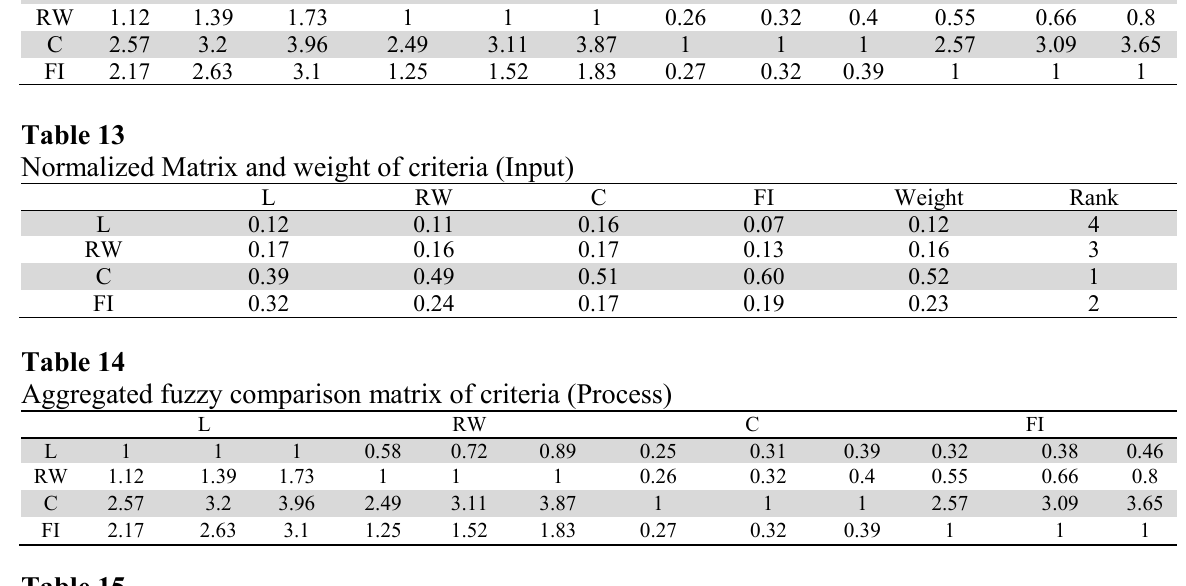
Normalized Matrix and weight of criteria (Process) T